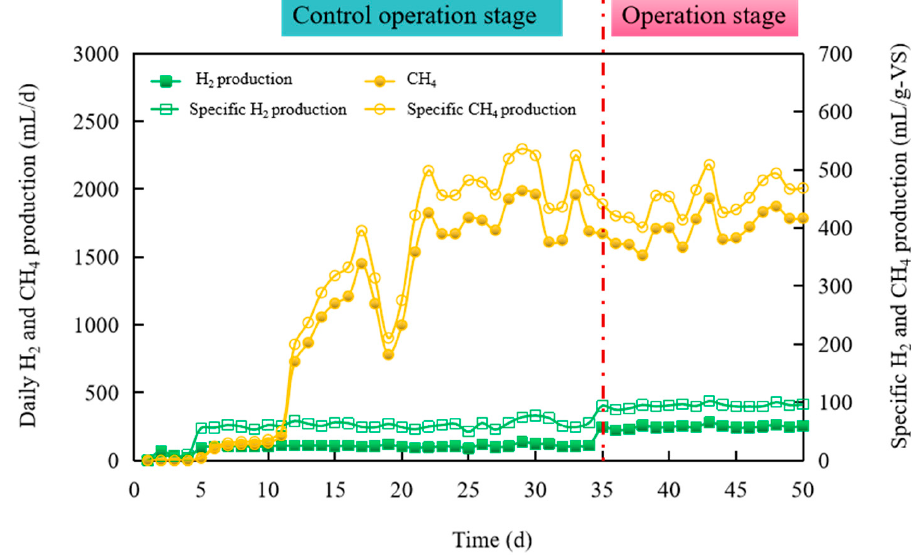
Figure 4. The variation in specific H 2 and CH 4 production yield during different operation stages and